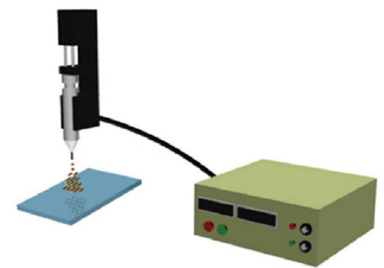
Figure 8. Scheme of the electrospray deposition system to synthesize gliadin-based nanoparticles. Reprinted with permission from [57]; copyright (2012) American Chemical Society.